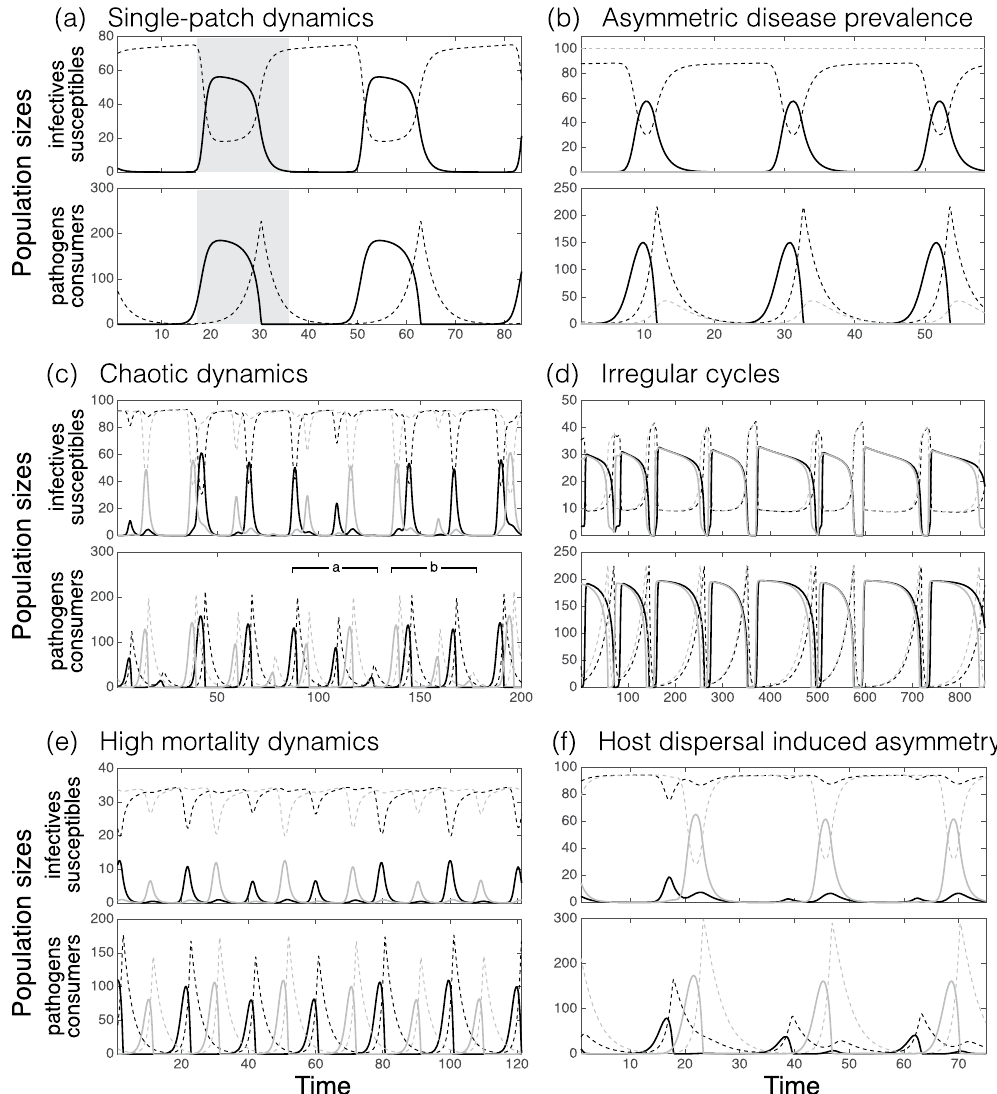
Figure 1. Six different representative classes of cyclic dynamics from model simulations. A line color indicates population’s habitat patch (a black or grey patch). In each picture, an upper panel shows the number of infected hosts (solid line) and susceptibles (dotted line) over time and a lower panel shows the number of pathogens (solid line) and consumers (dotted line) over time. ( a ) Single-patch dynamics ( a = 0.55, h = 0.45, κ = 3, λ = 0.1), where shaded areas make easier to compare dynamics between infectives and pathogens. ( b ) Asymmetric disease prevalence case (via consumer dispersal) showing one infected and one healthy patch ( a = 0.55, h = 0.25, κ = 3, λ = 1, d con = 0.15). ( c ) Example of chaotic dynamics ( a = 0.55, h = 0.25, κ = 3, λ = 0.1, d host = 0.1, ν = 0.01), where intervals a and b show the effect of indirect pathogen flow (sequences of decreasing pathogen populations). ( d ) Example of irregular cycles ( a = 0.55, h = 0.85, κ = 3, λ = 0.5, d host = 0.1). ( e ) Example of dynamics under a high mortality rate ( a = 0.55, h = 0.25, κ = 3, λ = 0.1, d host = 0.1, ν = 0.15). ( f ) Asymmetric disease prevalence caused by host dispersal ( a = 0.55, h = 0.25, κ = 3, λ = 1, d host = 0.11). Notice that population sizes (y-axis) and time intervals (x-axis) vary between